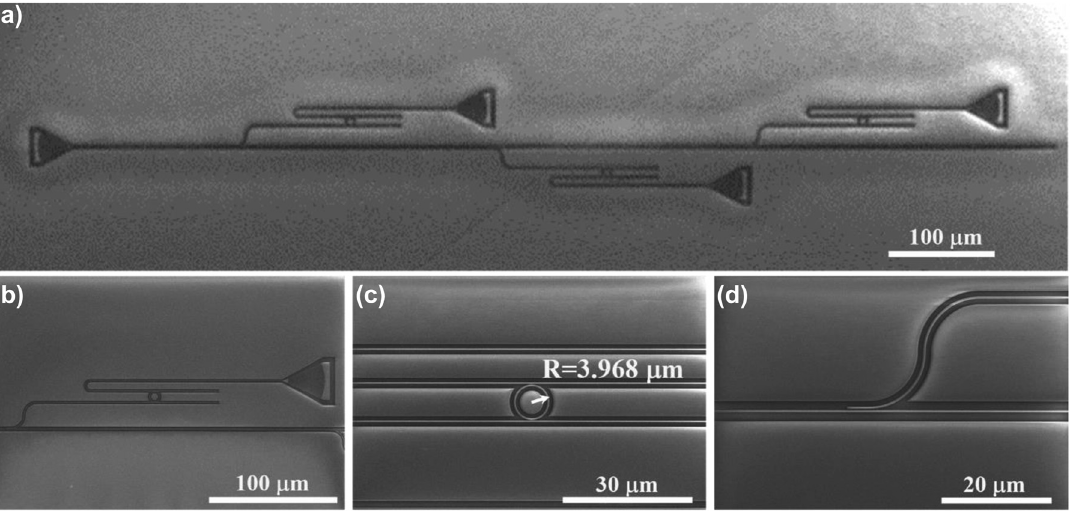
Figure 3: The SEM images of (a) the micro-ring resonator array. (b) A single unit in MRRAS. (c) The micro-ring resonator with R = 3.968 μ m. (d) A directional coupler.